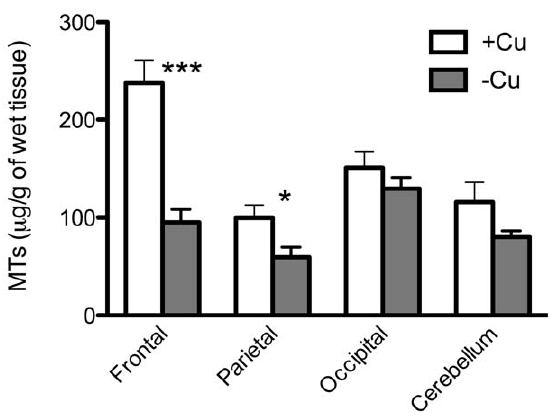
Figure 6. Metallothionein (MT) content in the brain. MT ( m g/g wet tissue) in the parietal, frontal, occipital cortex, and cerebellum. * p , 0.05; *** p , 0.001.